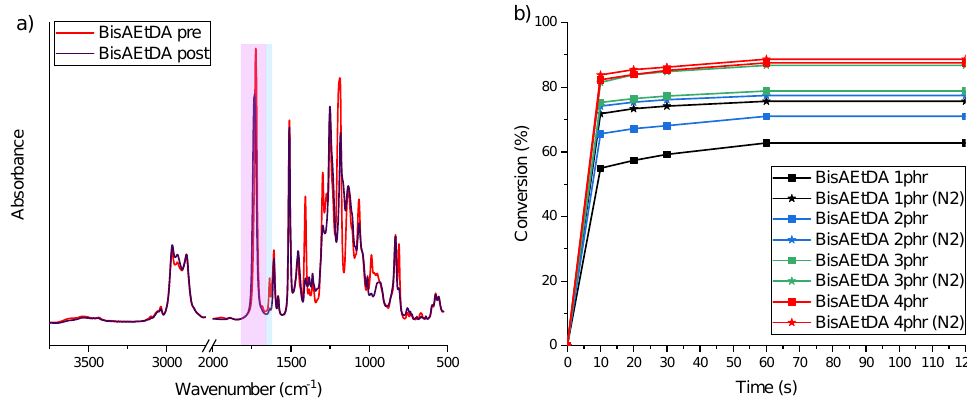
Figure 7. ( a ) FTIR spectra of the BisAEtDA formulation before and after UV irradiation; ( b ) FTIR C=C conversion at different irradiation time with and without inert atmosphere.